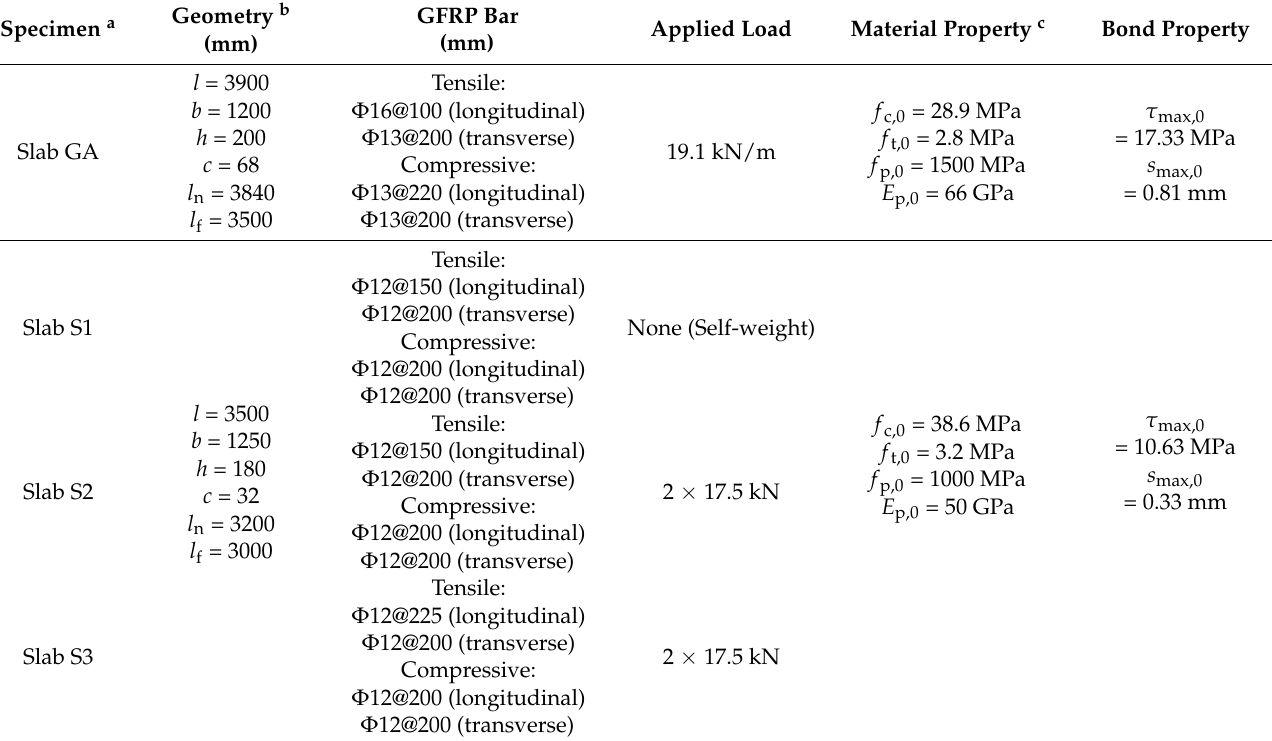
Table 1. Geometric and material properties of the tested specimens.